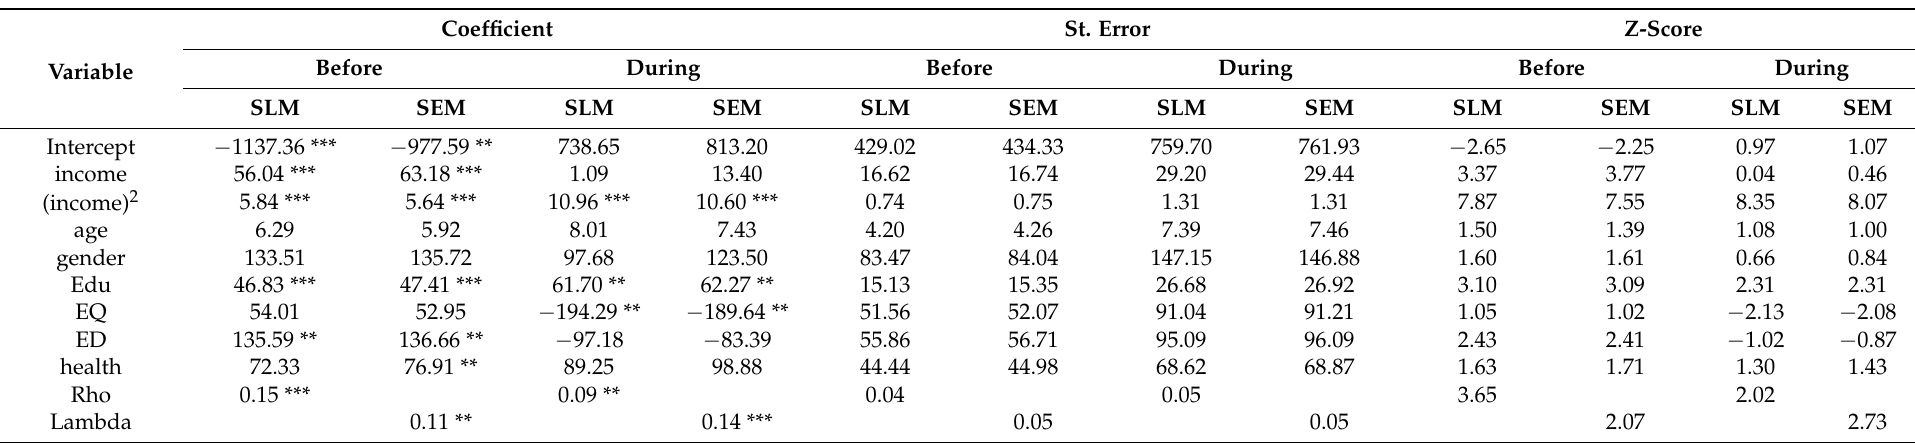
Table 6. Summary statistics of SLM, and SEM for WTPEP before and during